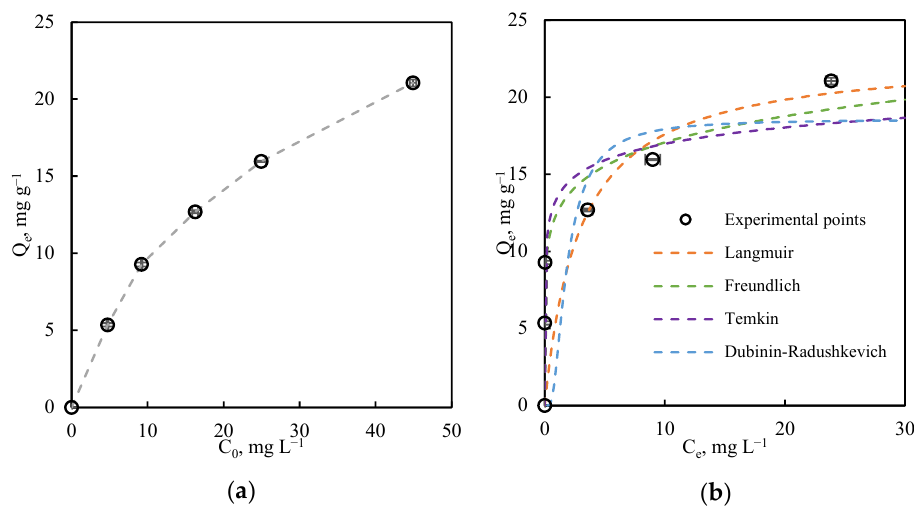
Figure 3. ( a ): Effect of initial Cu (II) concentration on adsorption capacities of waste marble sludges and ( b ): experimental adsorption isotherms and isotherm model plots for the removal of Cu (II) in ultrapure water by waste marble sludges (25 °C, pH = 6).